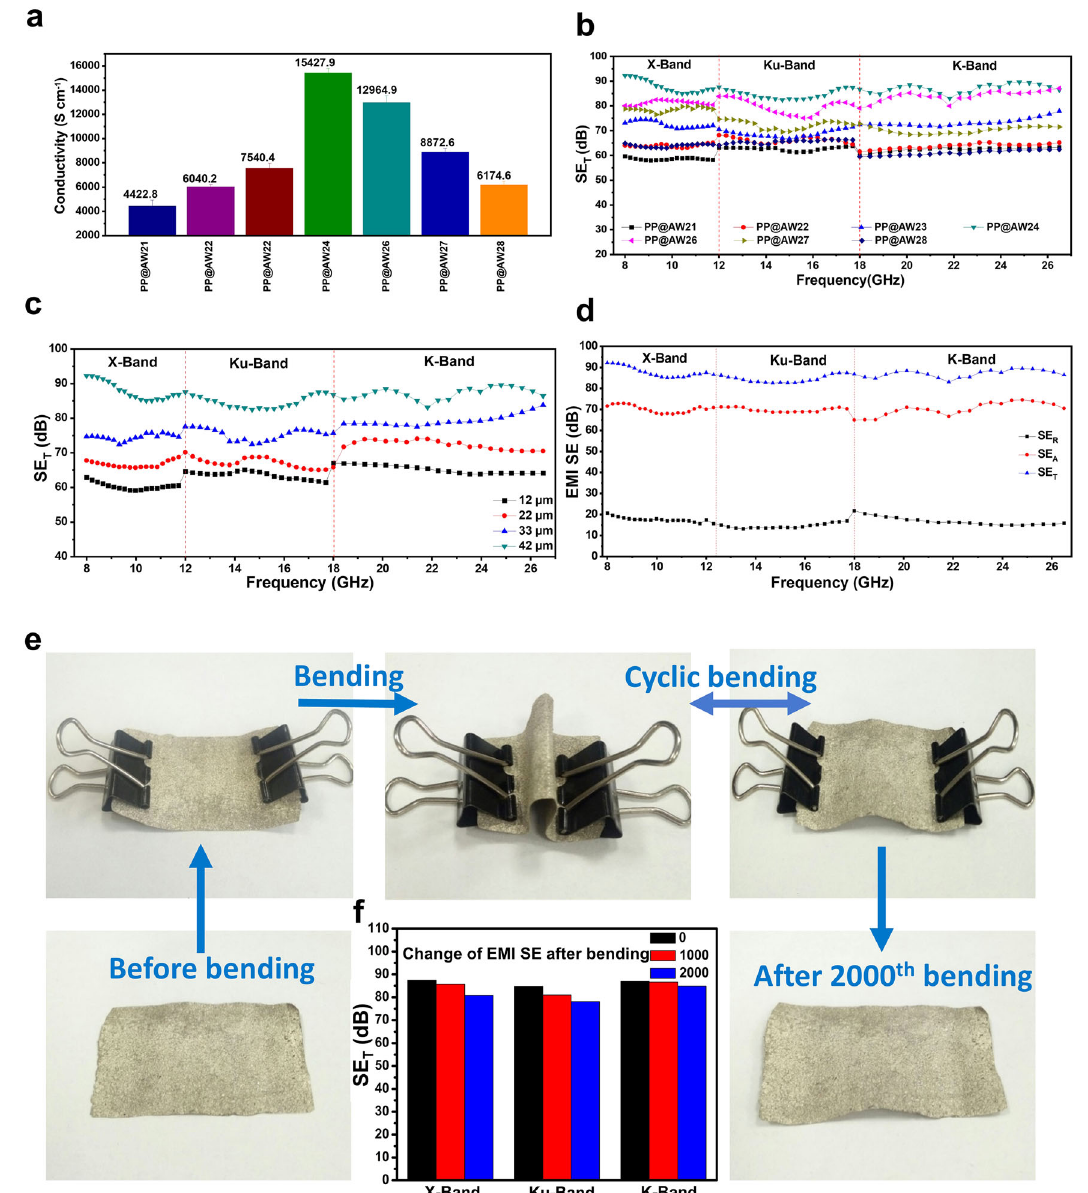
Fig. 2 Electrical conductivity, microwave shielding, and mechanical properties of PP@AW hybrid membranes. a Electrical conductivity of PP@AW hybrid membranes with different Ag/W ratios. b Microwave shielding effectiveness SE T of PP@AW hybrid membranes with different Ag/W ratios. c SE T of PP@AW24 hybrid membranes with different thicknesses. d Shielding performance of PP@AW24 hybrid membranes, the detailed contribution of SE A and SE R to total SE T and their dependence on frequency. e Mechanical fl exibility and durability of hybrid membranes. The PP@AW24 membrane was fl exible enough to retain its structural integrity even after 2000 bending cycles and there were negligible changes in its SE T values as shown in f